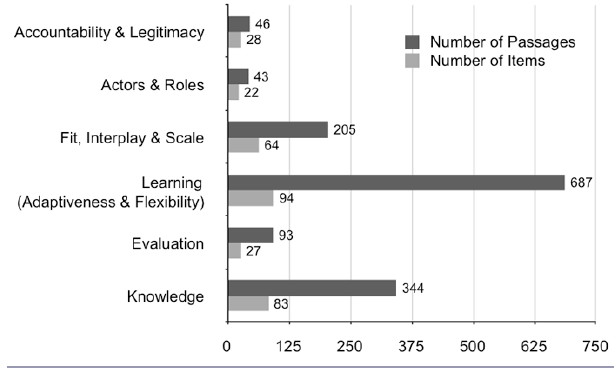
Fig. 1 . The appearance of key governance concerns in the ACM